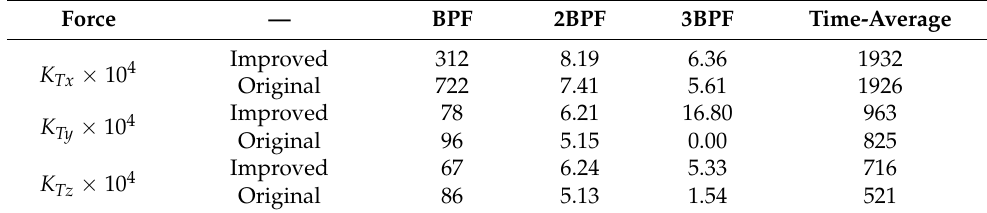
Figure 13. Frequency–domain fluctuation curves of propeller loads. Table 5. The fluctuation peak of the propeller thrust and side